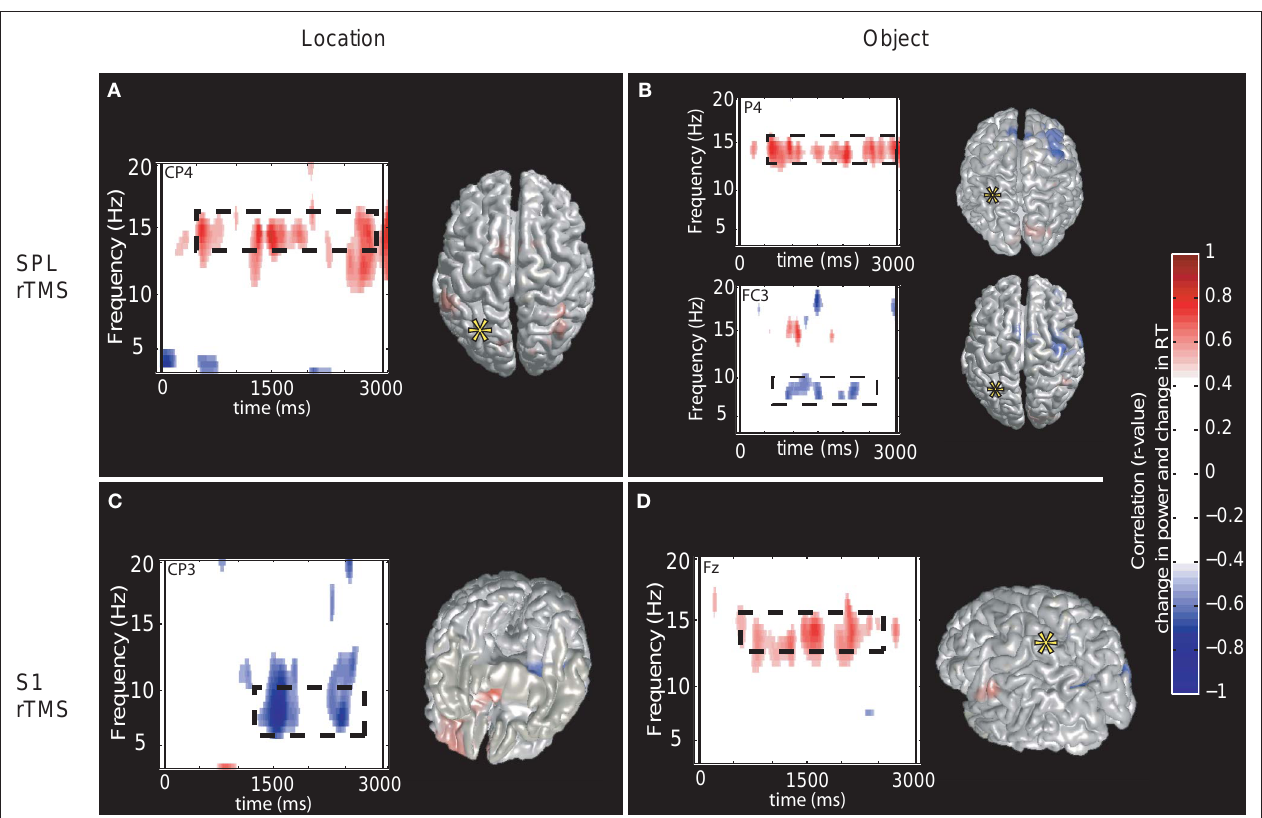
FIGURE 6 | Topographic and source maps of correlation between rTMS- induced change in oscillatory power and RT. (A,B,D) For three task conditions (SPL/location memory, SPL/object memory and S1/object memory), there was a positive correlation between rTMS-induced change in power at 14–16 Hz and RT. (B,C) For two task conditions (SPL/object memory and S1/location memory), there was a negative correlation between rTMS-induced change in power at 7– 10 Hz and RT. Topographic and surface plots were calculated after averaging